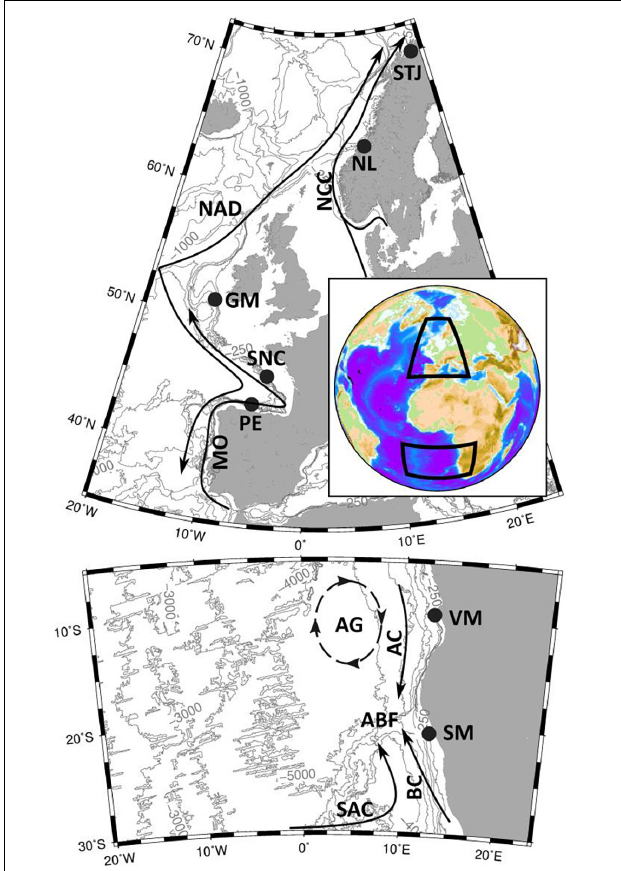
FIGURE 1 | The study sites on the Eastern Atlantic continental margin with main currents. The 250 m, 500 m, 1000 m, 2000 m, 3000 m, 4000 m and 5000 m depth contours are shown based on the ETOPO-1 bathymetry grid. STJ, Stjernsund; NL, Nordleksa; GM, Galway Mound; SNC, St. Nazaire Canyon; PE, Pagés Escarpment; VM, Valentine Mound; SM, Sylvester Mound; NCC, Norwegian Coastal Current; NAD, North Atlantic Drift; MO, Mediterranean Overflow; AG, Angola Gyre; AC, Angola Current; SAC, South Atlantic Current; BC, Benguela Current; ABF, Angola-Benguela